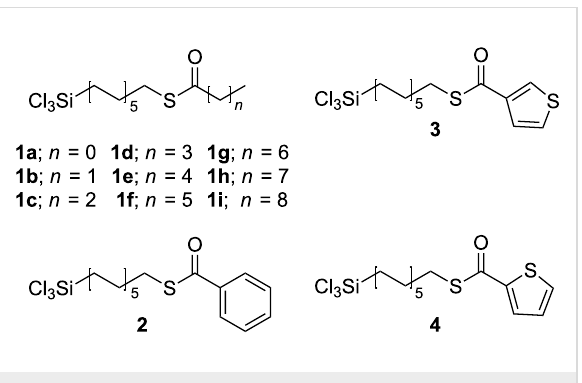
Figure 1: Trichlorosilyl